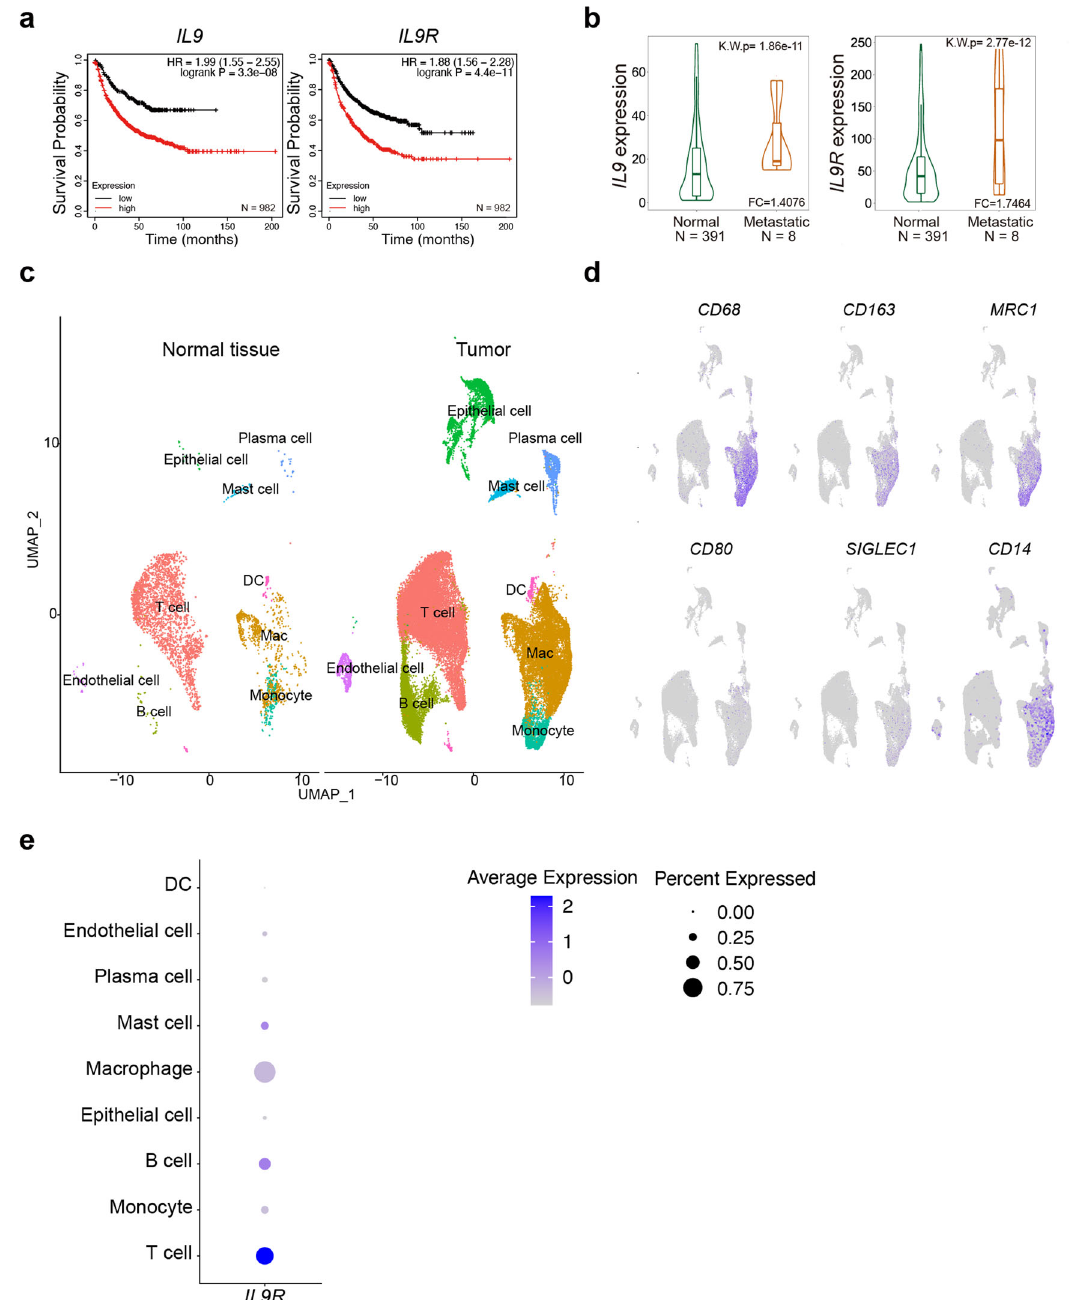
Fig. 1 TAMs express IL9R in lung cancer patient tissue. a Kaplan-Meier plots showing differences in survival among lung cancer patients ( n = 982) using data derived from published transcriptomic data and online tools described in the Methods for IL9 and IL9R . HR: hazard ratio. b Comparison of gene expression in normal lung tissue and metastatic lung tissues by using data derived from published transcriptomic data obtained by gene-array and online tools described in the “ Methods ” . FC: fold change. K.W.p Kruskal – Wallis p value. The bars represent the proportions of metastatic tumor samples that show higher expression of the selected gene compared to normal samples at each of the quantile cutoff values (minimum, 1st quartile, median, 3rd quartile, maximum). c UMAP showing clusters from normal and lung tumor tissue from human lung cancer patients. DC, dendritic cell. d UMAP showing gene expression. e Dot plot showing IL9R expression in different expression of CD206, which is associated with immunosuppres- signaling was lost (Supplementary Fig. 1j). Differences from the sion (Supplementary Fig. 1k, l). Other cell types were not altered observed populations in naive lung may be due to the tumor- in the absence of IL-9 signaling in this model (Supplementary promoting environment 24,25 . To further detect phenotypic changes Fig. 1m, n). By injecting B16 cells to INFER IL-9 reporter mice, we of distinct lung macrophage populations, we stained markers found CD4 T cells were the major IL-9 producers in the lung related to co-stimulatory or immunosuppressive functions in the tumor environment (Supplementary Fig. 1o). To con fi rm the B16 injection model. The CD11c − IM from WT mice exhibited lower co-stimulatory marker expression (CD86) and higher importance of IL-9 from T cells, mice with T cell-speci fi c ablation